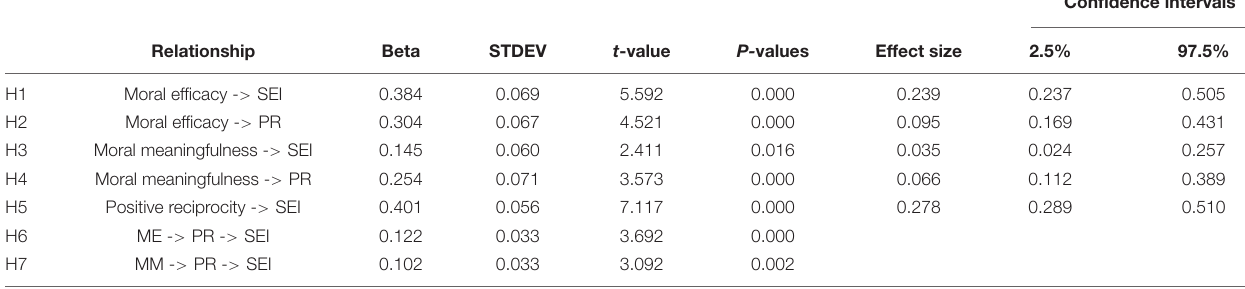
TABLE 5 | Path coefficients and